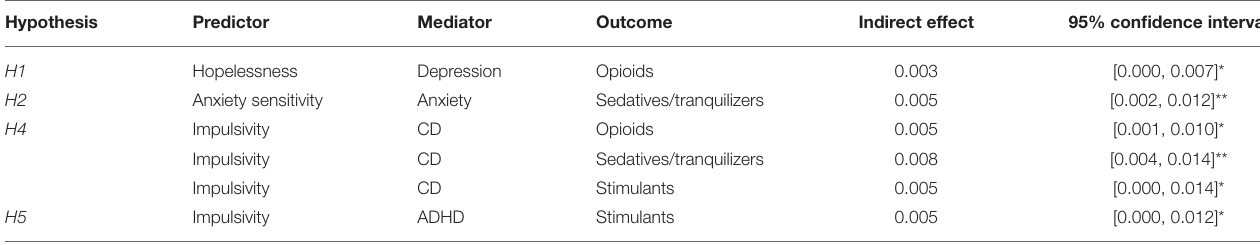
TABLE 4 | Tests of hypothesized indirect